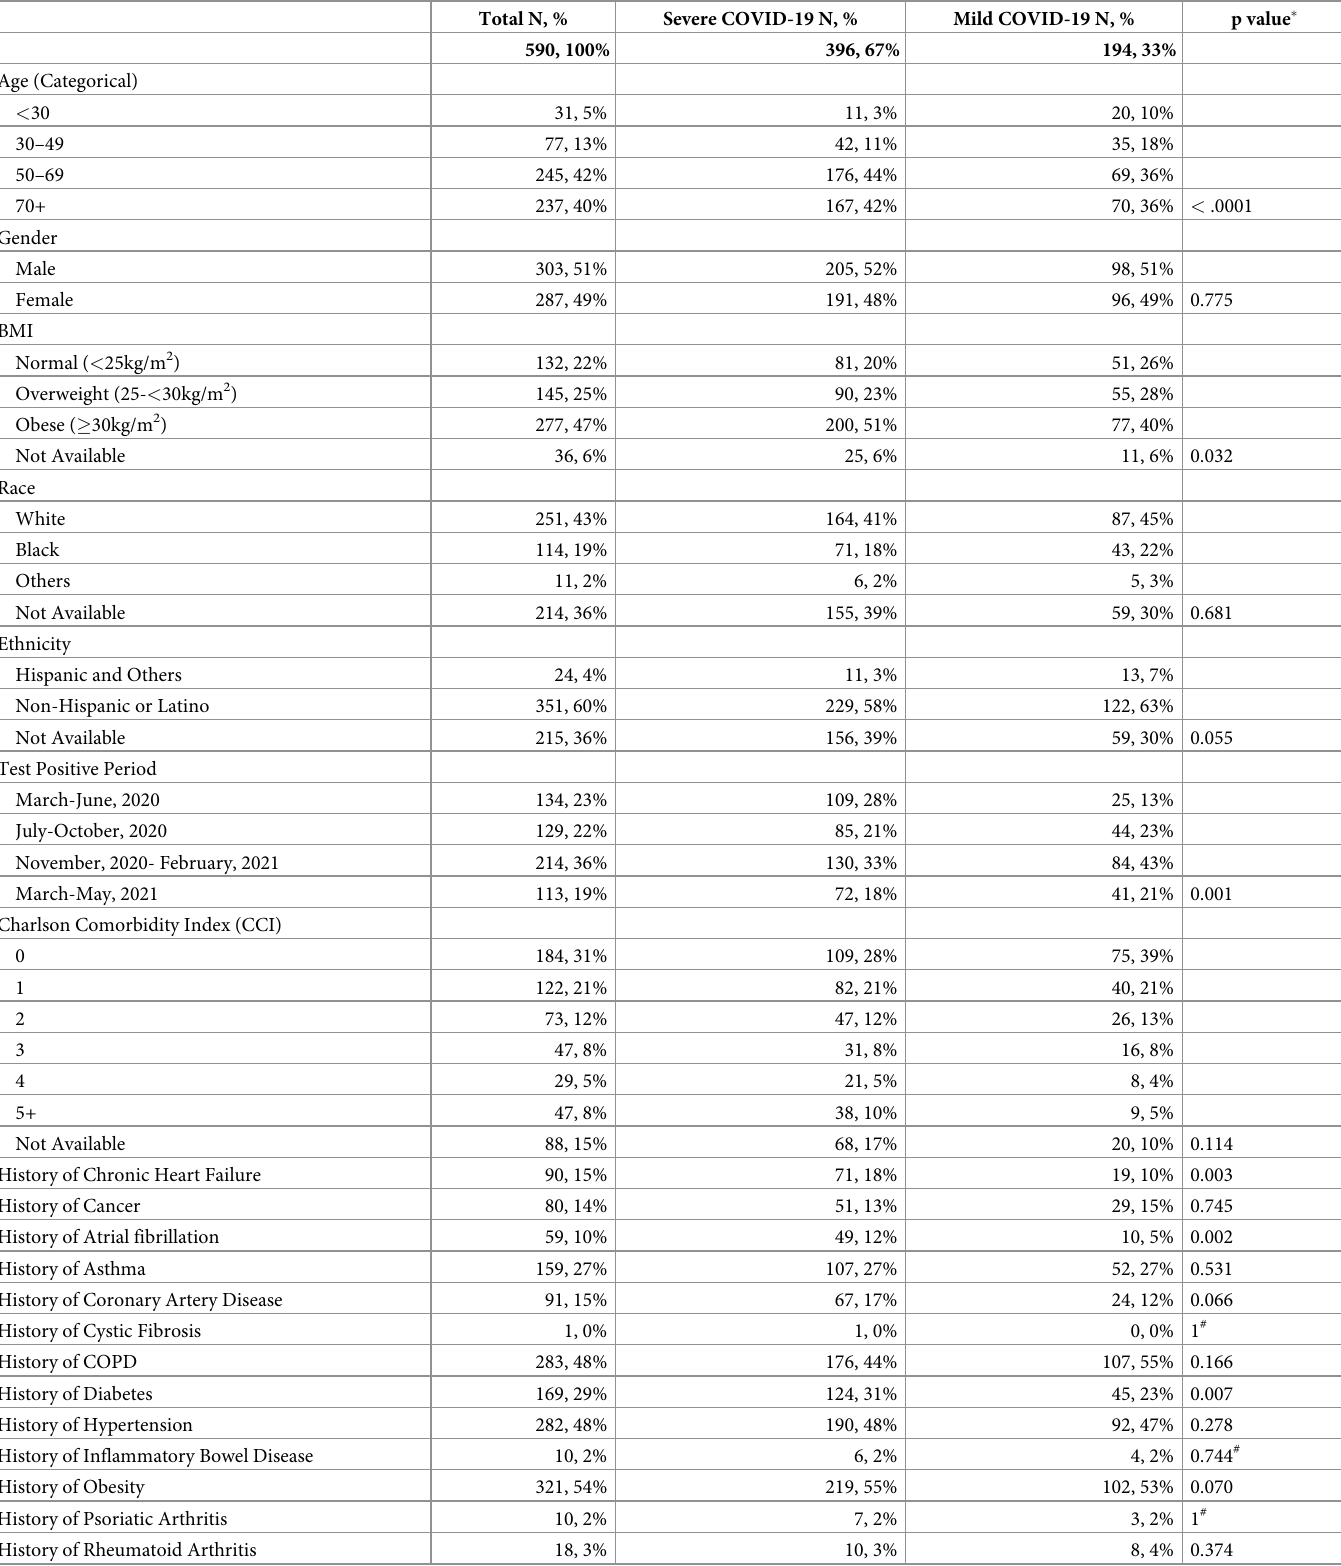
Table 1. Demographic characteristics and treatment and disease history information of UPMC COVID-19